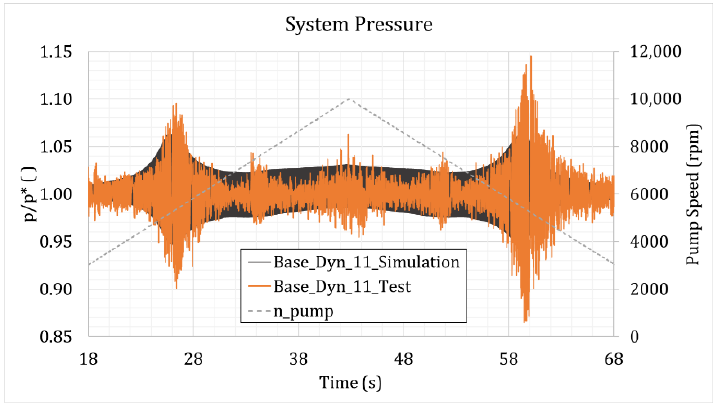
Figure 10. Validation of the Base_Dyn_11 numerical model: Simulation vs. Test.